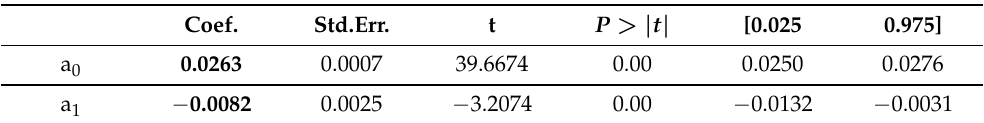
Table 2. Estimation of temperature dependent absorption parameters with measured data from 1850 to 2014. Coef. Std.Err. t P > | t |